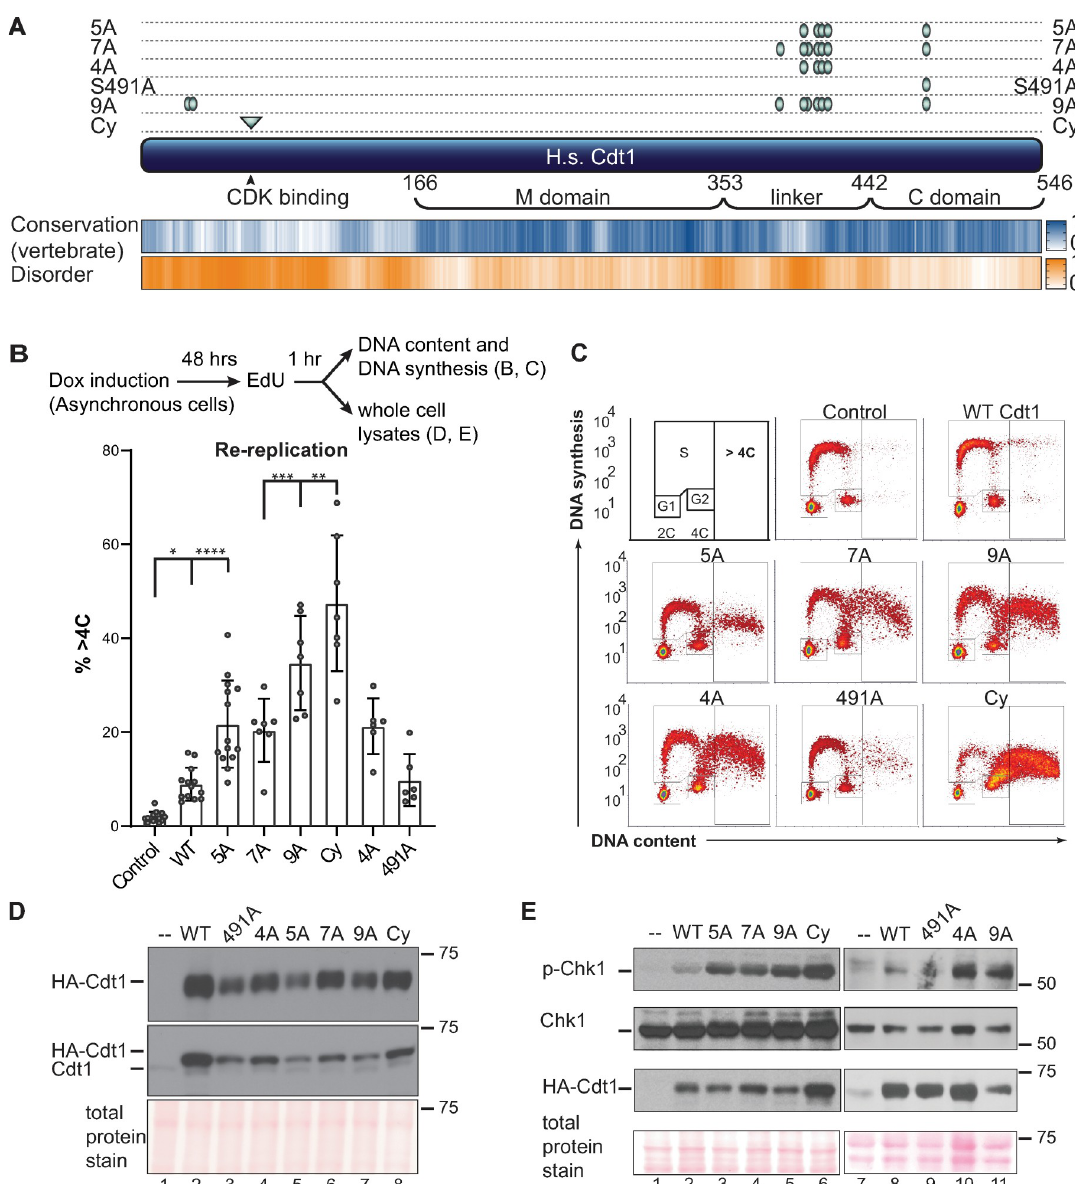
Fig 1. Cdt1 phosphorylation restrains re-replication. A ) Schematic of the human Cdt1 protein illustrating features and variants relevant to this study. Cdt1 contains two structurally characterized domains, the Geminin and MCM binding domain (M) and a C- terminal MCM binding domain (C). The Ser/Thr-Pro sites that were altered for this study are marked with green ovals, and the cyclin binding motif is marked with a green triangle. Positions are T29, S31, S372, S391, S394, T402, T406, S411, and S491; the cyclin binding motif (Cy) is 68–70, and the Cdt1-2E3D mutant in Fig 5 bears glutamate and aspartates at same sites as the alanines in Cdt1-5A. Human Cdt1 was aligned with 26 vertebrate Cdt1 sequences using ClustalW, and a relative conservation score was derived (see also Methods and S1 Fig). The blue heatmap indicates relative conservation at each amino acid position of human Cdt1. An intrinsic disorder score was also derived for human Cdt1 and shown as the corresponding orange heatmap. Darker shades indicate greater conservation or disorder respectively. B ) Asynchronously growing U2OS cells with the indicated chromosomally-integrated inducible Cdt1 constructs were treated with 1 μ g/mL doxycycline for 48 hours and labeled with EdU for 1 hour before harvesting. Cells were analyzed by flow cytometry for DNA content with DAPI and for DNA synthesis by EdU detection; the workflow is illustrated at the top. The bar graph plots the percentages of re-replicating cells across all experiments. Bars report mean and standard deviations. Asterisks indicate statistical significance determined by one-way ANOVA ( � p = 0.0175, �� p = 0.0023, ��� p = 0.007, ���� p < 0.0001); 5A vs 7A, 5A vs 4A and WT vs 491A were not significant as defined by p > 0.05. C ) One representative of the multiple independent biological replicates summarized in B is shown. D ) Whole cell lysates as in B were subjected to immunoblotting for ectopic (HA) or endogenous and ectopic Cdt1; Ponceau S staining of total protein serves as a loading control. E ) Asynchronously growing U2OS cells were treated